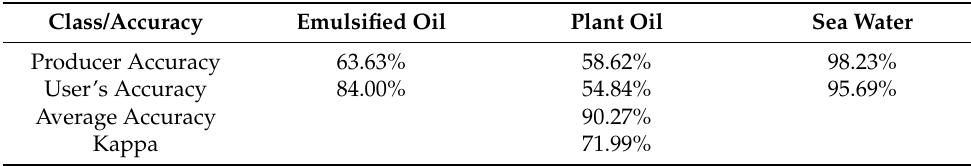
Table 6. Classification accuracies of random forest classifier in Case